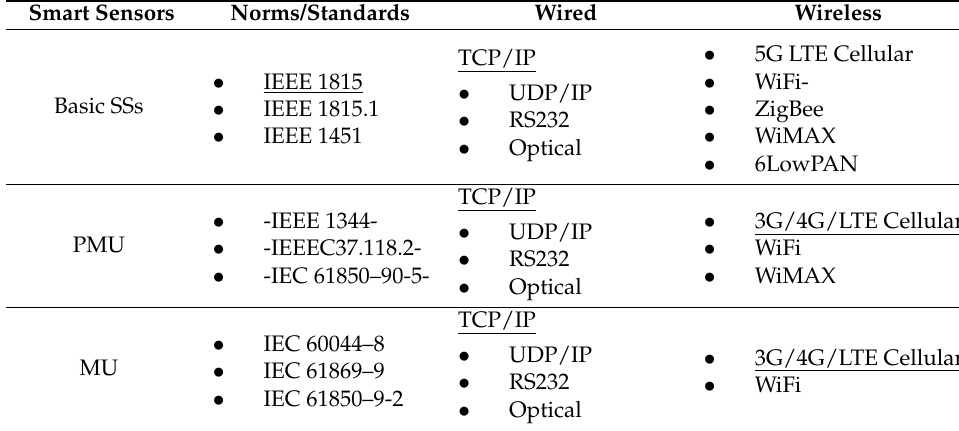
Table 2. SSs Standard Specifications.